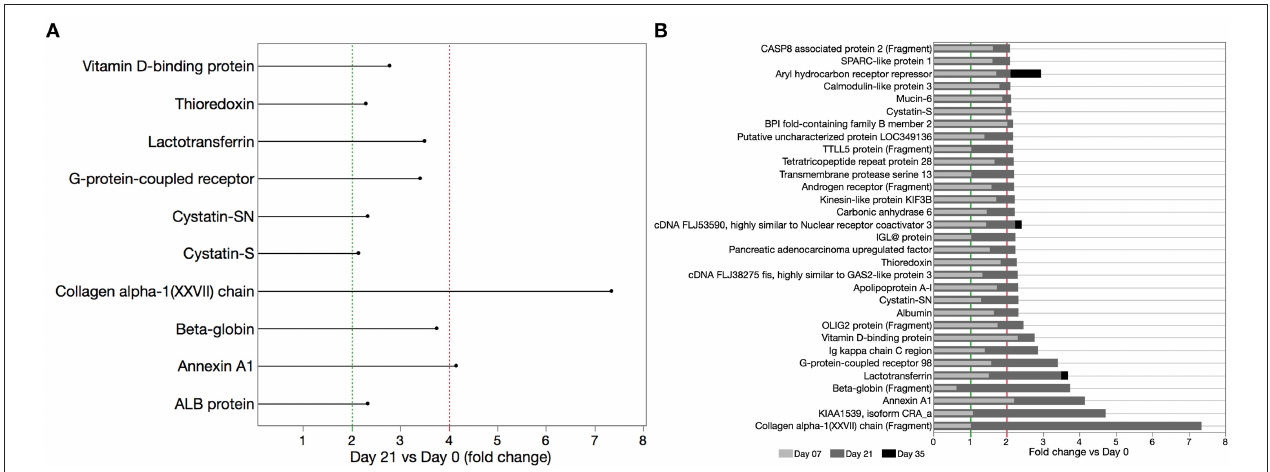
FIGURE 3 | Cytoprotective proteins significantly increased during EG (day 21 vs. day 0). (A) WS samples were analyzed by LC-ESI-MS/MS and relative proteome analysis performed based on peptide sequences obtained from the database search using SEQUEST algorithm after peak integration from acquired frames and SIEVE-assisted recognition of proteins form peptide sequences. (B) Time course of salivary protein levels for select proteins that increased by > 2 fold on day 21 vs. baseline. With exception of aryl hydrocarbon receptor repressor, cDNA FLJ3590 fis and lactotransferrin all proteins with > 2 fold increase in the inflammatory phase were reduced by day 35, 2 weeks after oral hygiene was